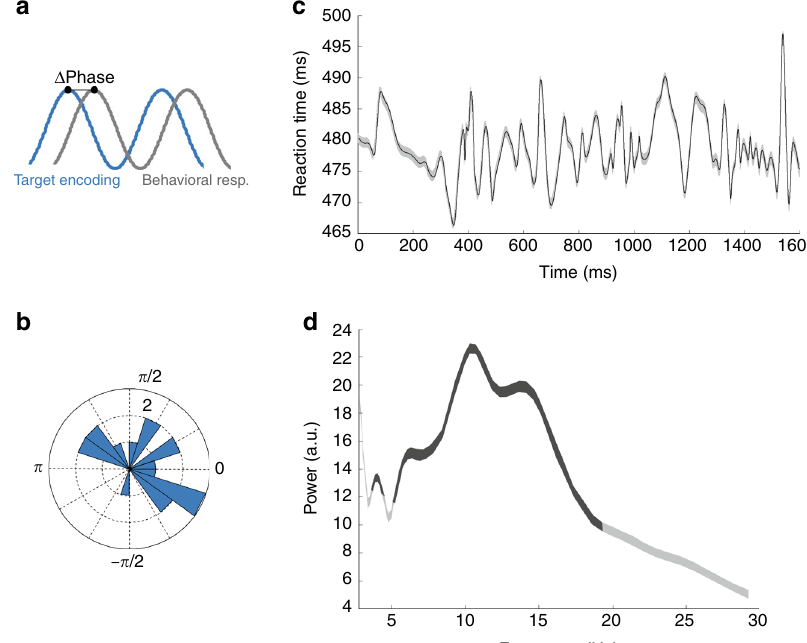
Fig. 6 Phase lag between optimal target encoding and optimal target detection behavioral response. a presents a session to session variability ( b ). c Changes in reaction times to target presentation as a function of time from cue presentation (detrended geometric mean + / − s.e). d Reaction time series power spectrum (mean + / − s.e., dark gray shaded areas, signi fi cance w/ 95%